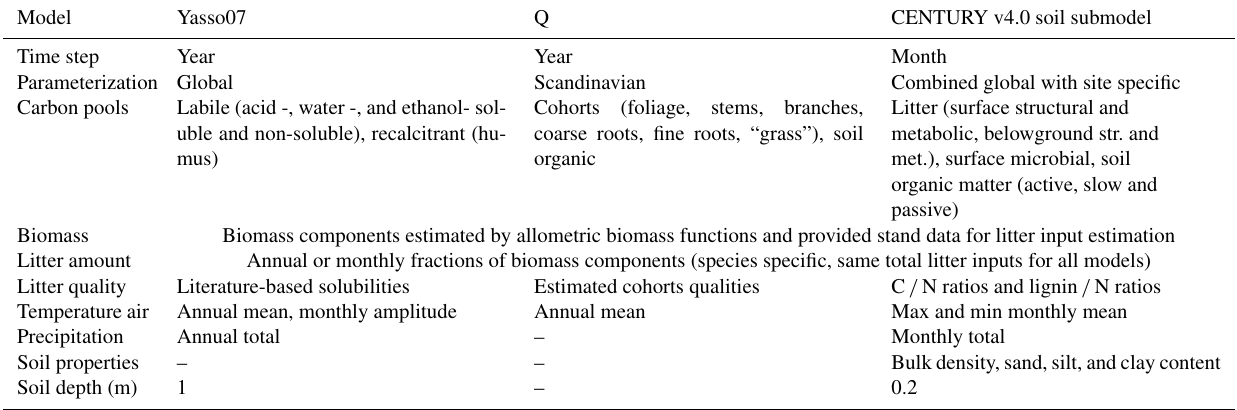
Table 3. Description of models and data inputs relevant for this study. Model